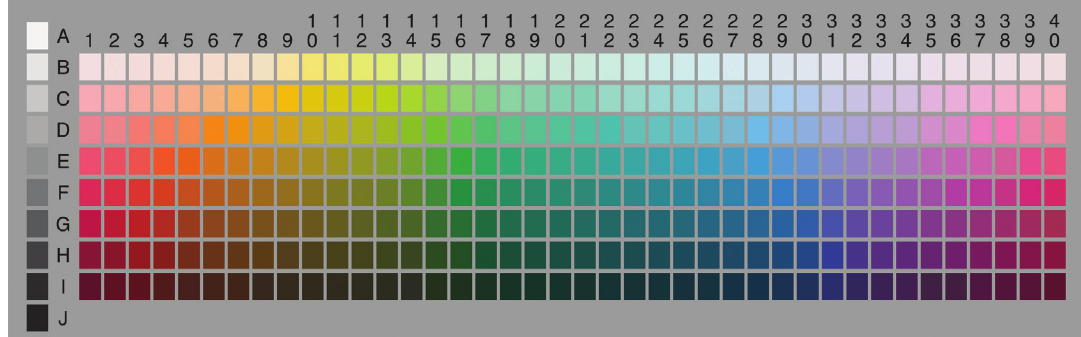
Figure 1: The array of 330 Munsell color chips used in the World Color Survey. Reproduced from Cook, Kay, and Regier with authors’ permission. The figure is only for the sake of illustration; faithfulness to the standardized physical set of Munsell chips is generally not guaranteed with screening or printing